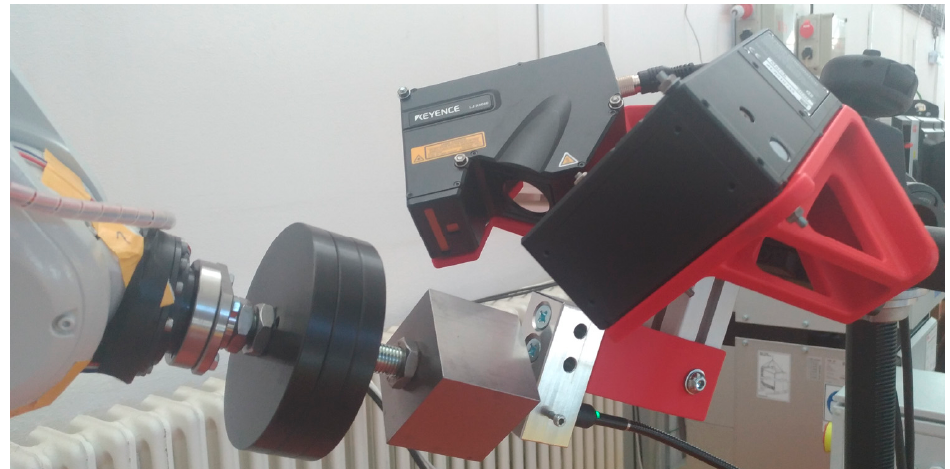
Figure 4. Measuring nest. A robot with the payload tool approaches to confocal sensor that measures the TCP Z-axis distance. TCP X and Y are measured by a pair of laser profilers above the payload tool.